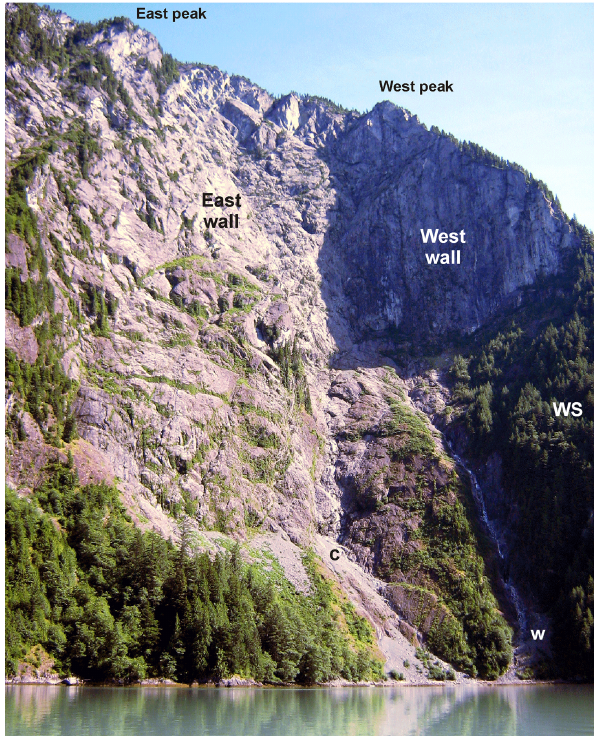
Figure 3. Oblique photograph of the rock slope at Adeane Point. WS: west slope; c: central gully; w: west gully.